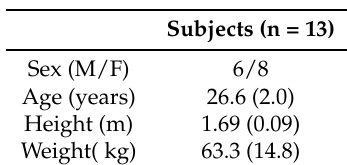
Table 1. Baseline characteristics of studied Healthy Subjects. For age and height, the mean and standard deviations are displayed.